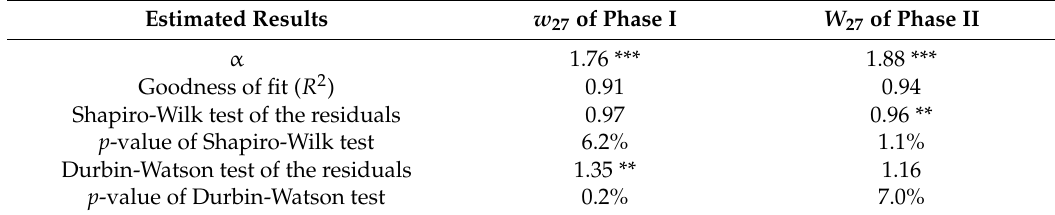
Table 4. Power law